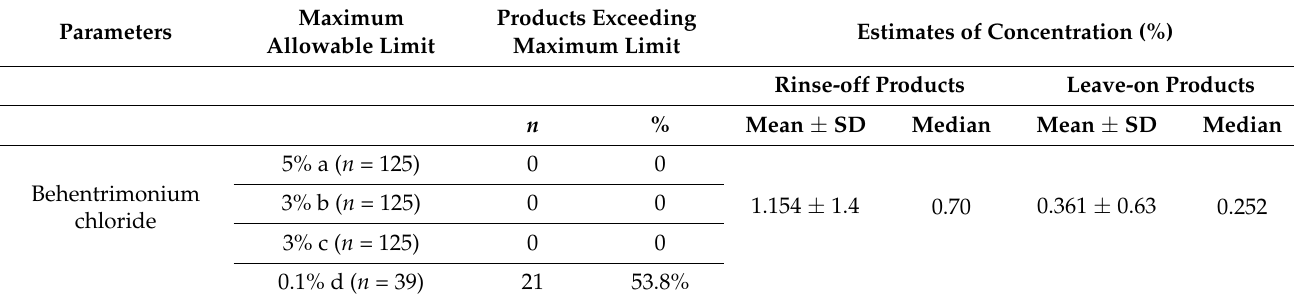
Table 4. Estimates of Behentrimonium chloride content from cosmetics and personal care products and Maximum Allowable Limit ( n =